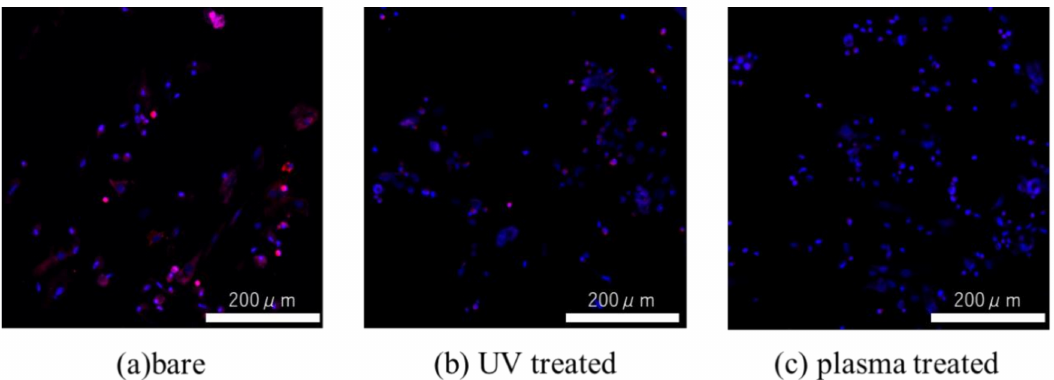
Figure 10. Fluorescent stained images of intracellular ROS of RBM mesenchymal stem cells seeded on ( a ) untreated, ( b ) UV treated, and ( c ) plasma-treated Ti